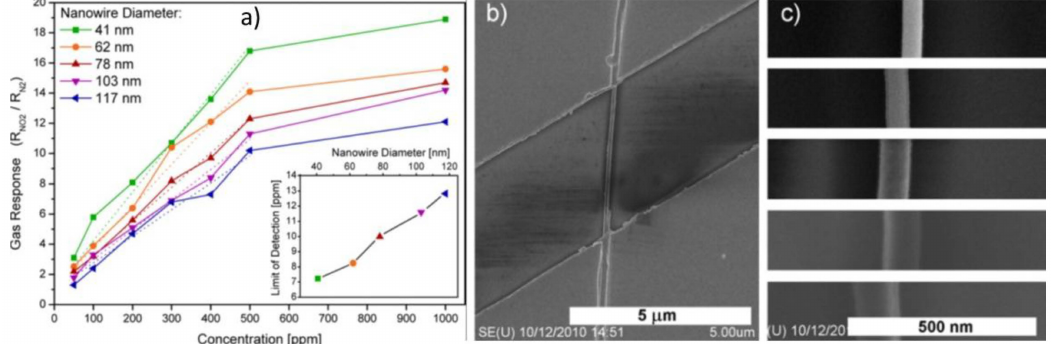
Figure 7. Gas responses of five single nanowire (SNW) sensors to various NO2 concentrations at 250 ˝ C ( a ), and SEM images of a single nanowire connected to the electrodes ( b ) and and the NWs with different diameters ( c ) (from the bottom to the top: 117, 103, 78, 62, and 41 nm). Reprinted from [57] with permission from